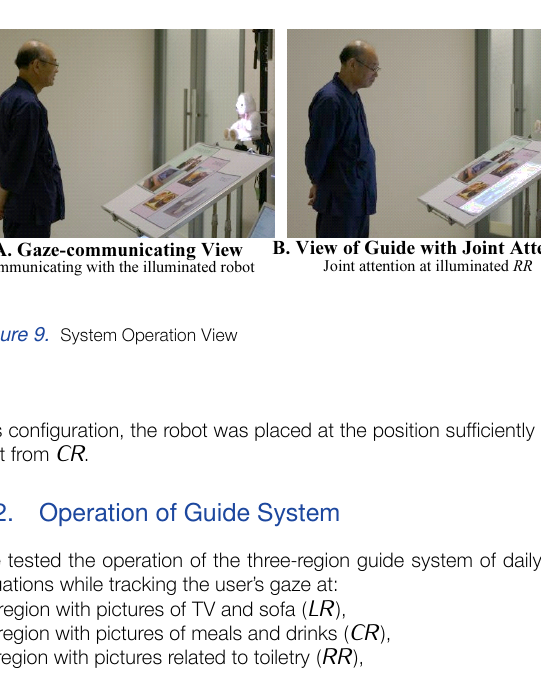
Figure 8. Example of System Operation Flow